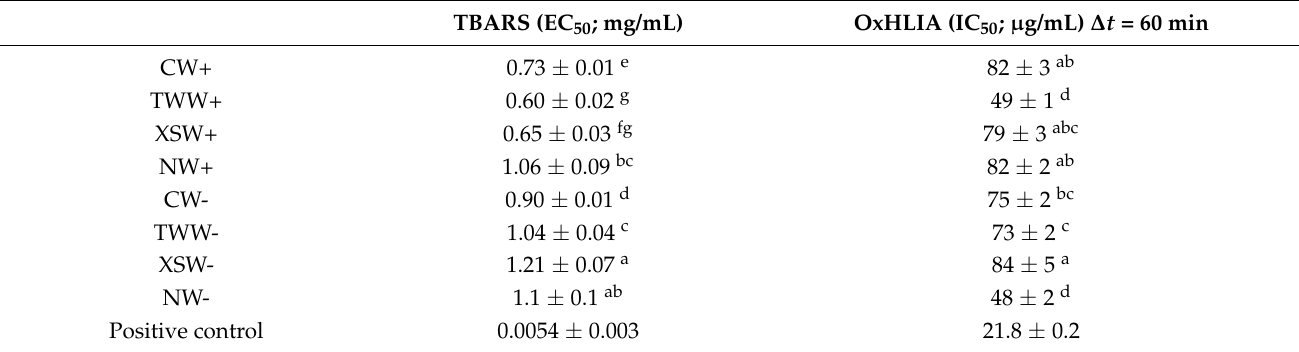
Table 4. Antioxidant activity of the studied tomato fruit hydroethanolic extracts in relation to irrigation regime and biostimulant treatment (mean ± SD, n =